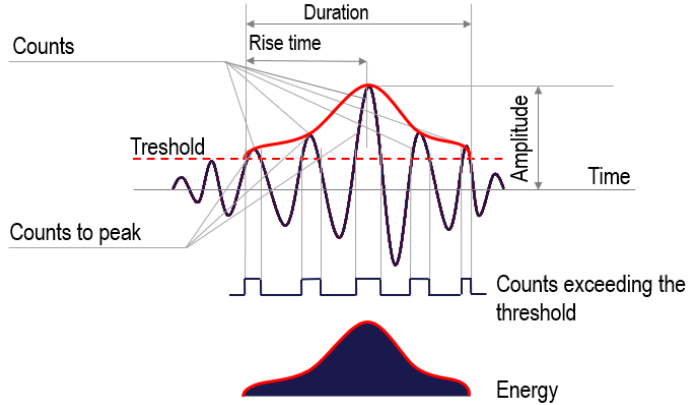
Figure 1. Acoustic signal parameters.